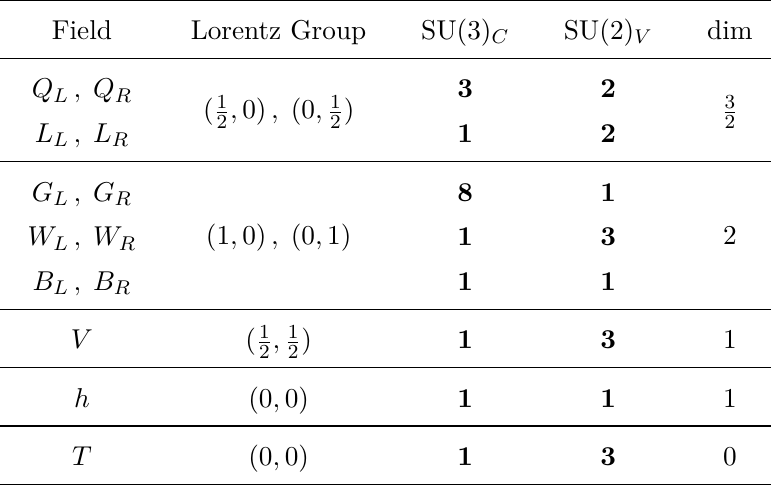
. We have included a spurion field T , which V V